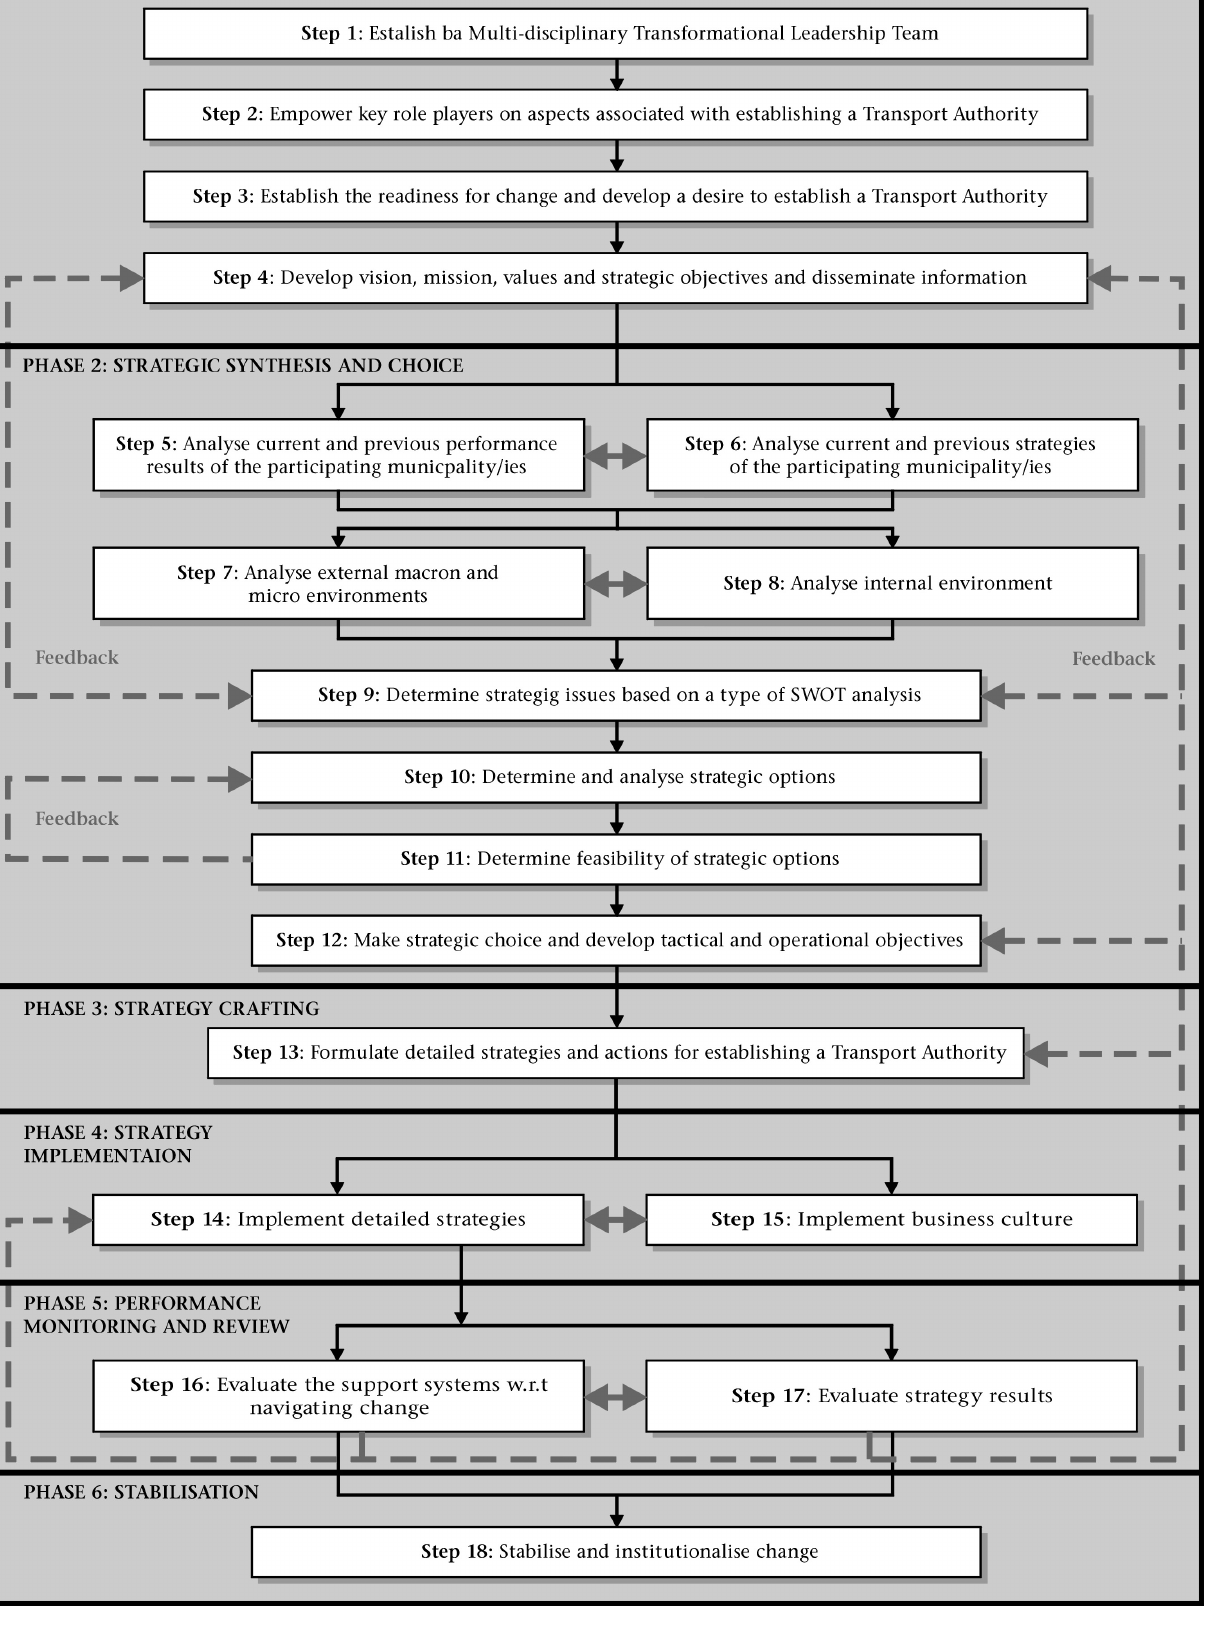
Figure 3: An Integrated Strategic Management Model to Navigate the Establishment of Transport